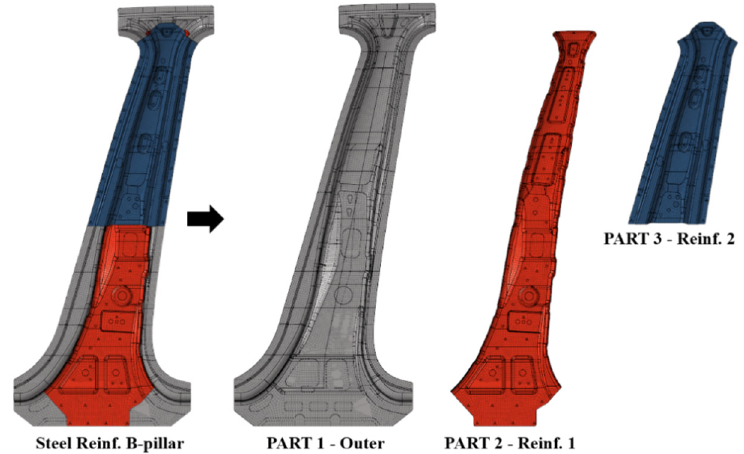
Figure 15. Components of center pillar with steel reinforcements. Table 3. Properties of center pillar with steel reinforcements.